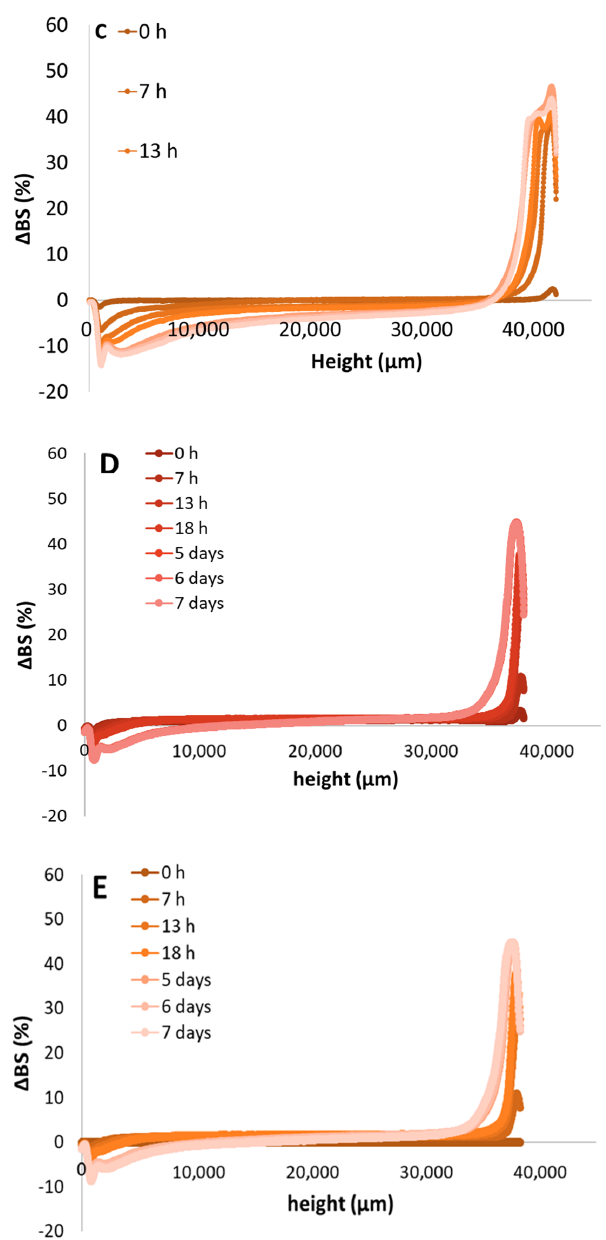
Figure 3. ΔBS (%) as a function of the height (µm) of the cell for Sigma and Norland ( A , B ), and from different extraction protocols ( C – E ) at time 0 h, 7 h, 13 h, 18 h, 5 days, 6 days and 7 days.